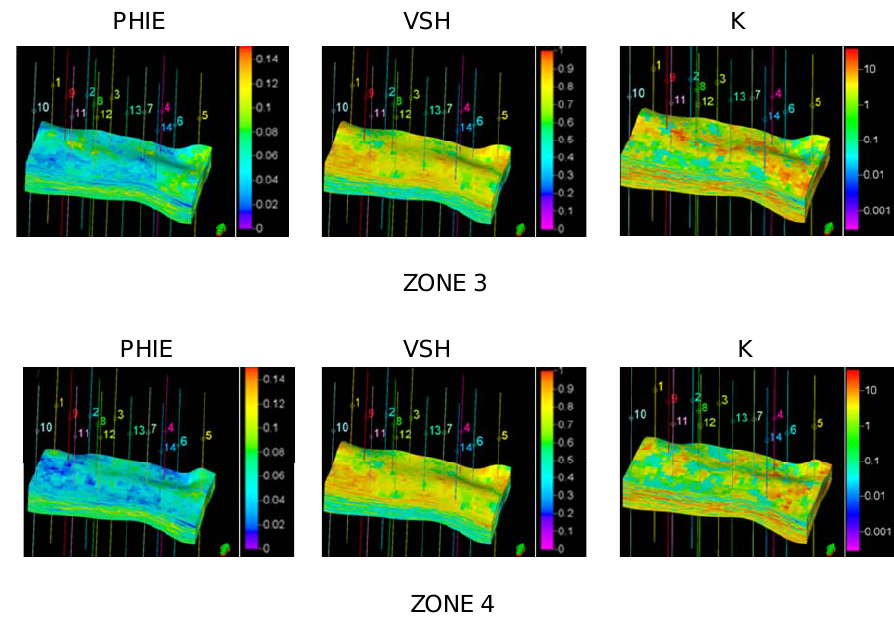
Fig. 8. Fractal distributions of effective porosity (PHIE), shale volume (VSH) and permeability (K) for zones 3 and 4.